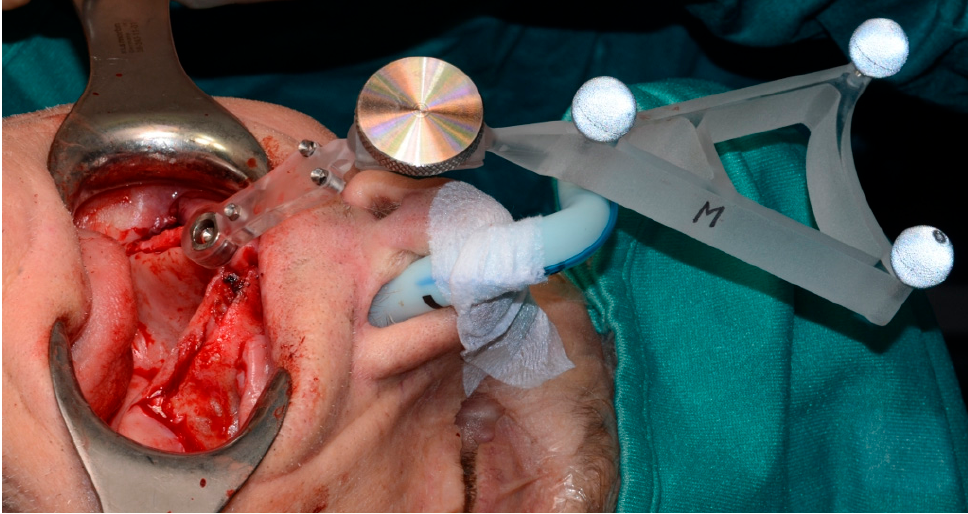
Figure 4. The intraoral reference tool in situ.